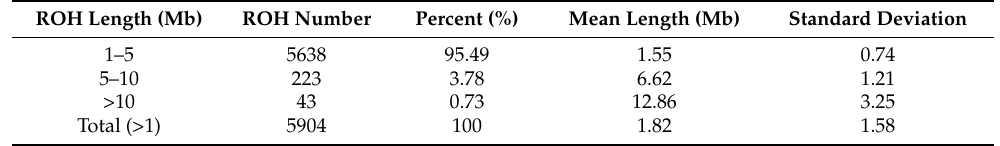
Table 3. Descriptive statistics for ROHs of different lengths (Mb): 1–5, 5–10, >10, and